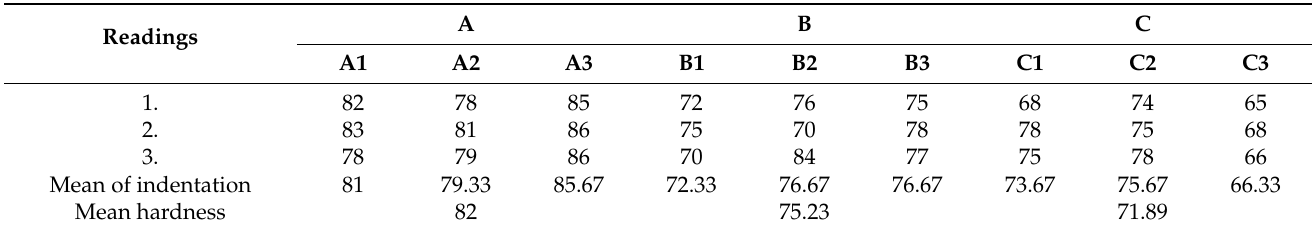
Table 4. Data analysis of Shore C hardness of three distinct